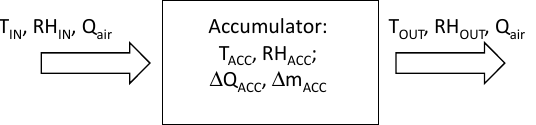
Figure 7. Input and output fluxes with processes occurring in the accumulator bed.